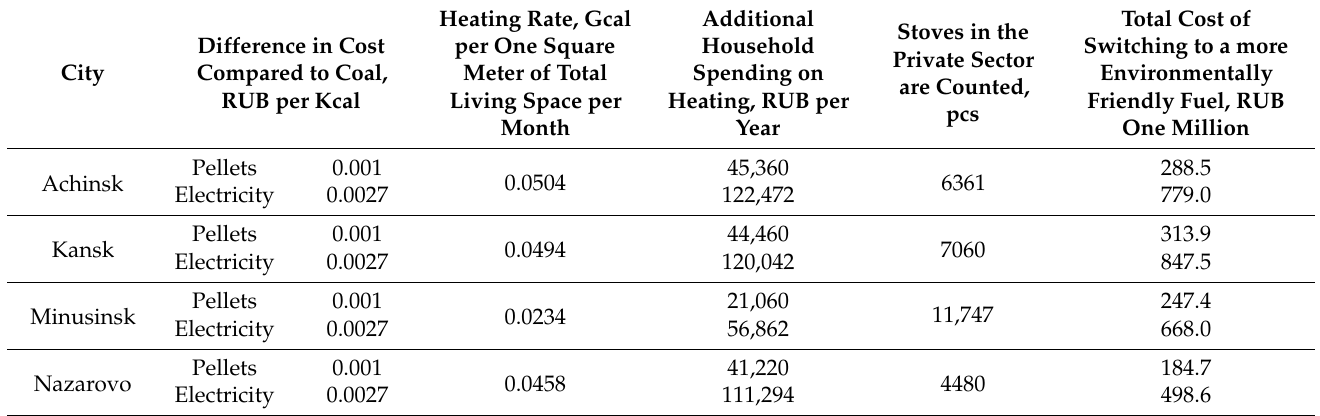
Table 9. Calculation of the total cost of converting individual heating to more